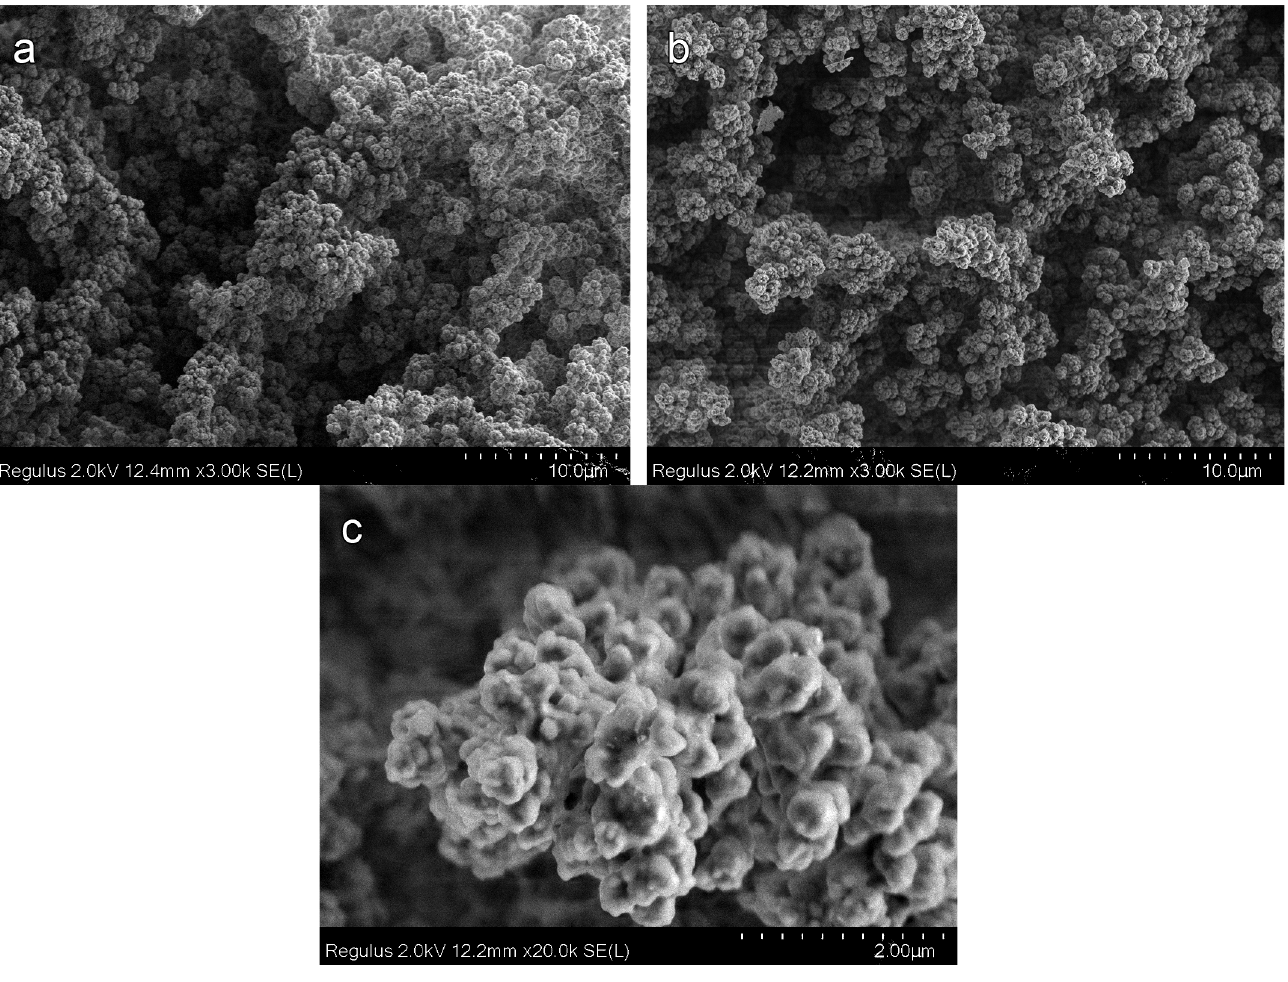
Figure 9. SEM micrographs cleavage surfaces ( a ) and outer surface of the sample side ( b , c ) of porous M14 (70 wt % alcohol content) monolith.